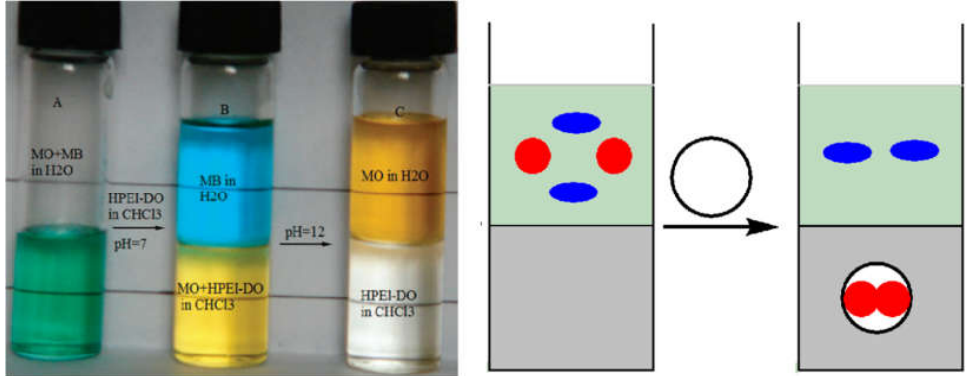
Figure 3. ( Left ) When HPEI-DO (PEI alkylated by dodecyloxirane) in chloroform is shaken with anionic methyl orange (MO) and cationic methyl blue (MB) in water at pH 7, the anionic dye MO is transferred to the bottom chloroform layer, while the cationic MB remains intact in the upper aqueous layer. If the pH is increased to 12, then MO is released into the water layer. ( Right ) Charge-selective encapsulation is responsible for dye separation [32].